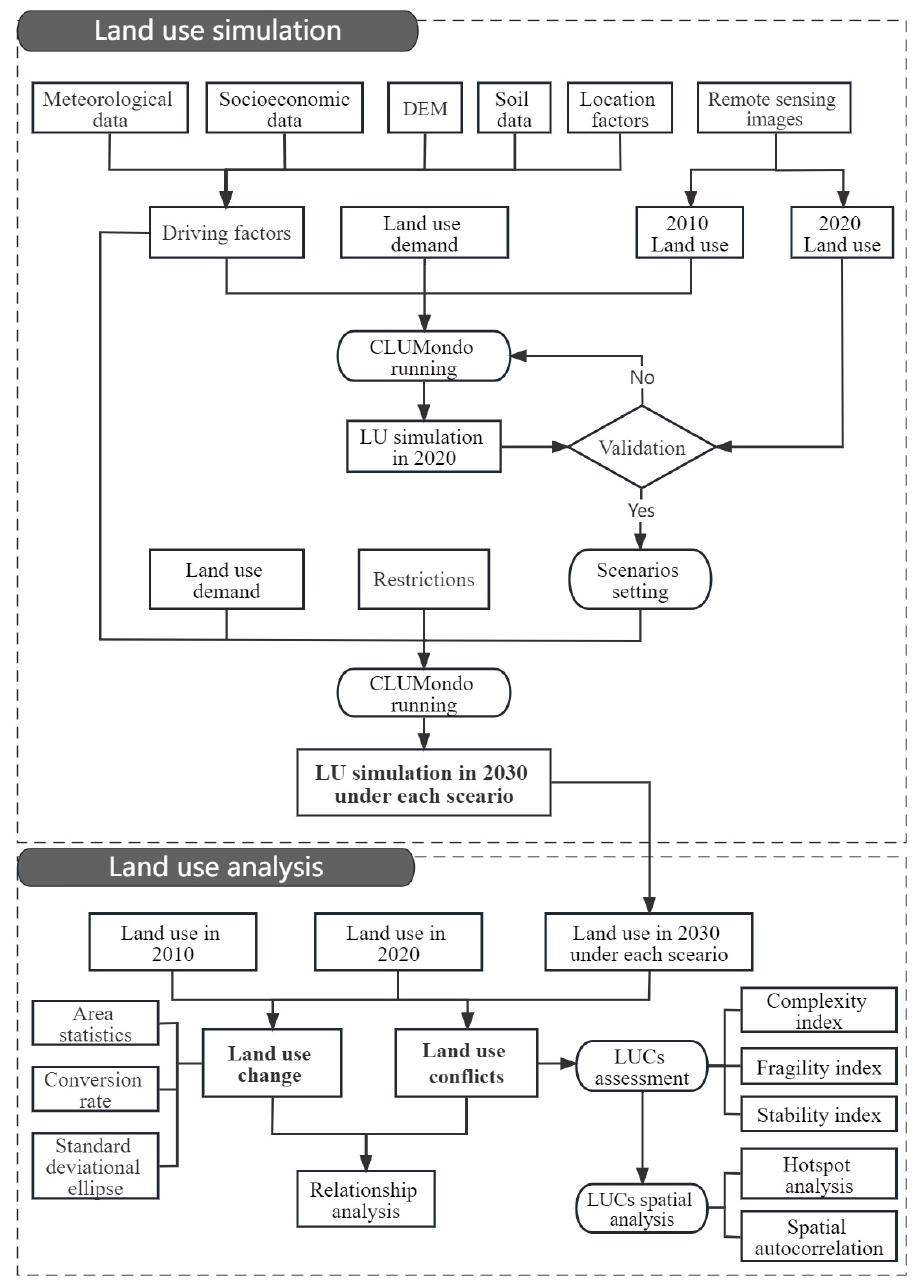
Figure 3. Technical fl ow chart.